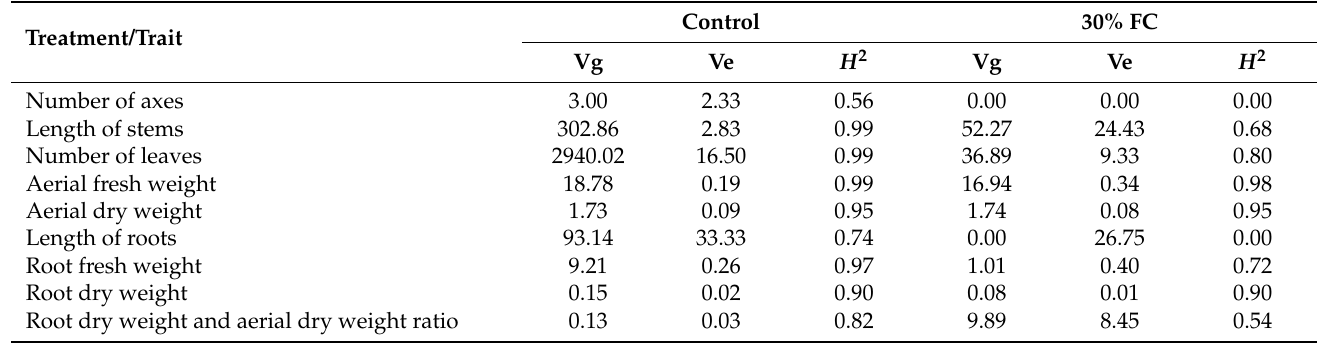
roots traits. Table 3. Genetic (Vg) and environmental (Ve) variances and heritability ( H 2 ) of measured traits for M. truncatula lines under control treatment and water deficit stress (30% FC).